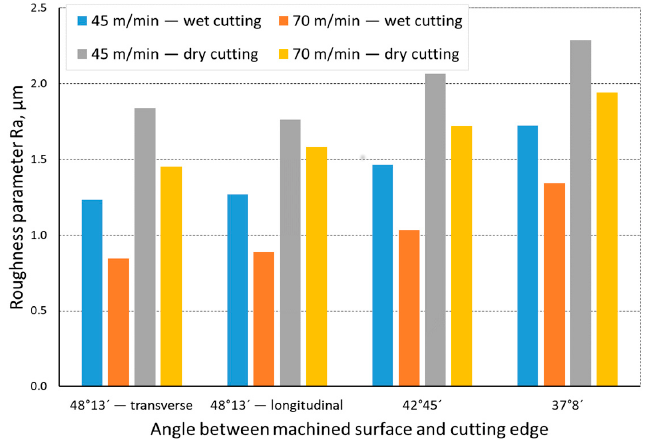
Figure 4. The impact of cutting speed on the variability of roughness parameter Ra in the function of the angle between the machined surface and cutting edge for a rectilinear track and a material hardness of 23 HRC.